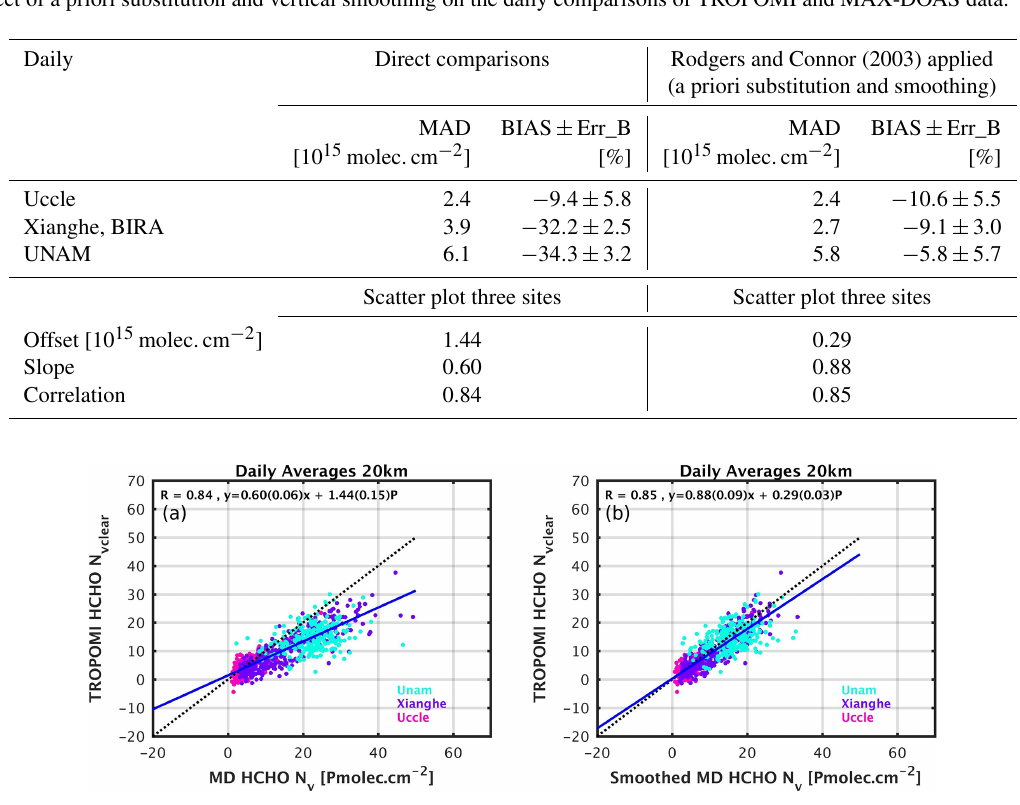
Table 5. Effect of a priori substitution and vertical smoothing on the daily comparisons of TROPOMI and MAX-DOAS data.